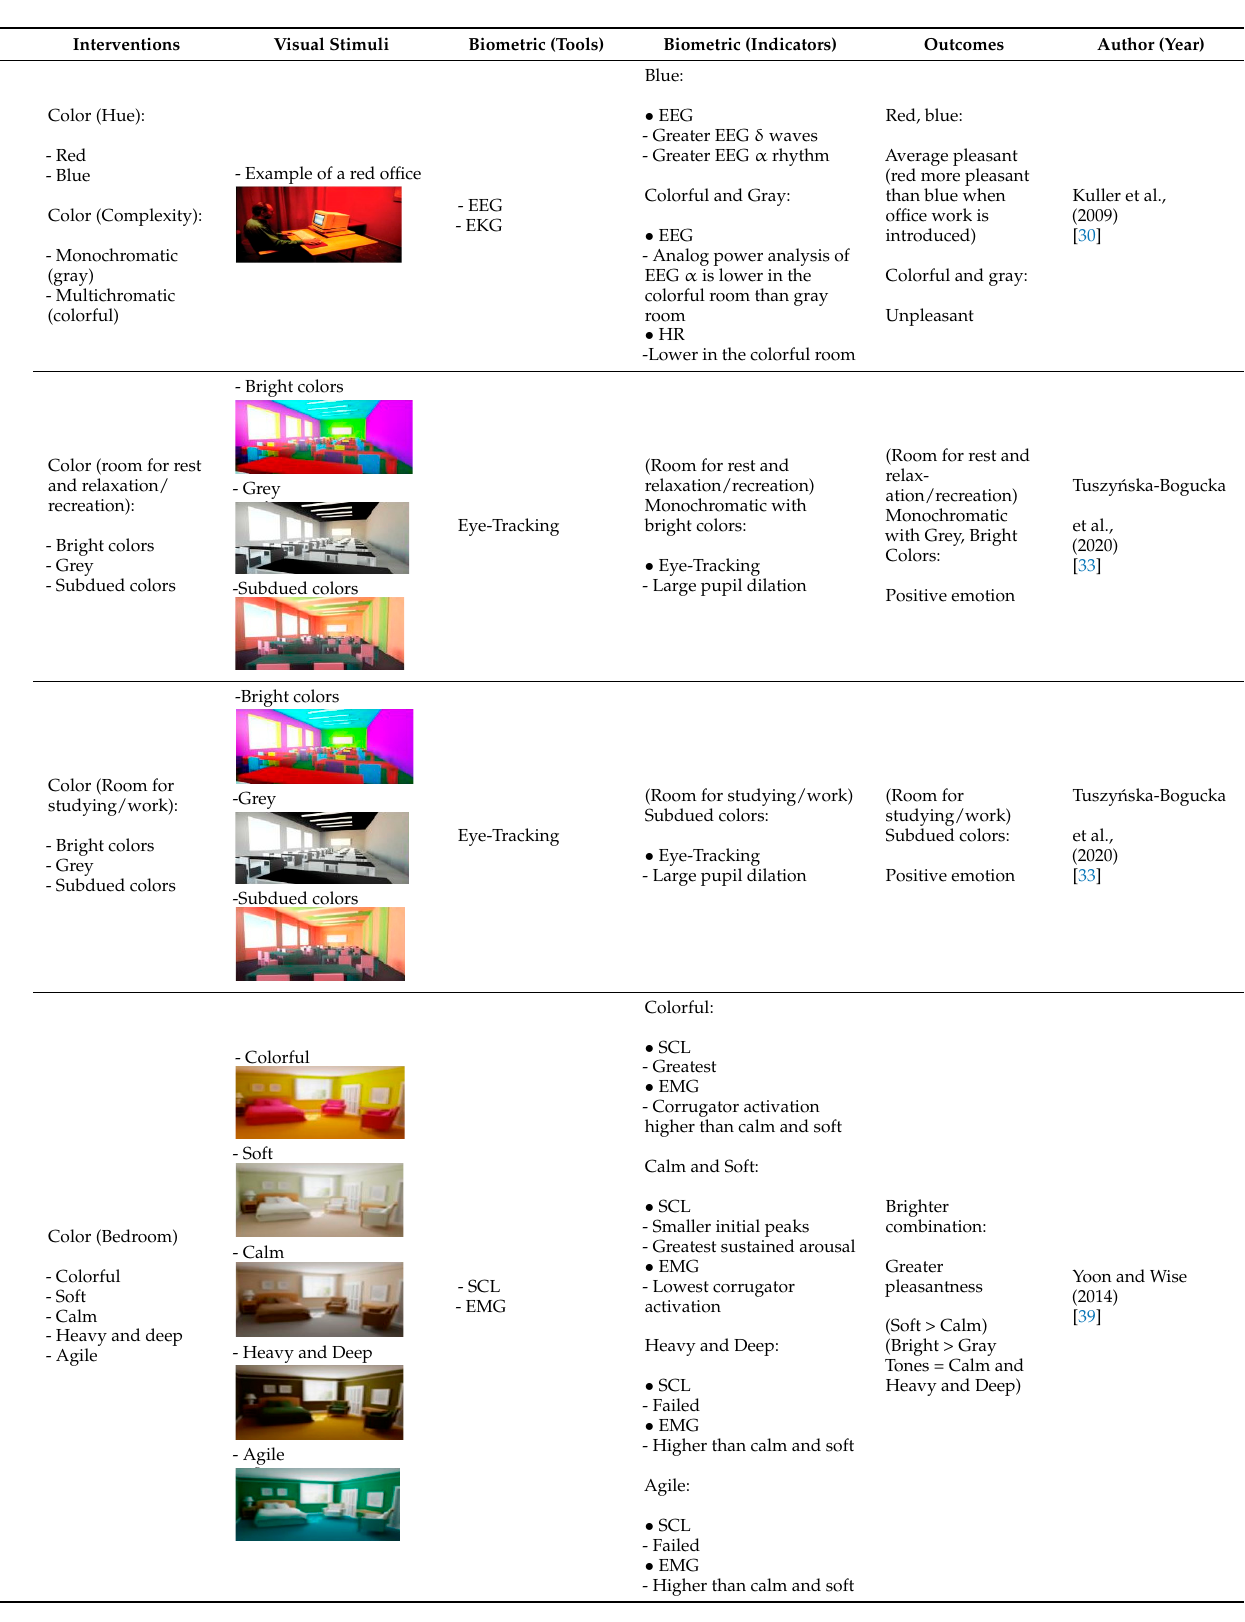
Visual Stimuli Biometric (Tools)